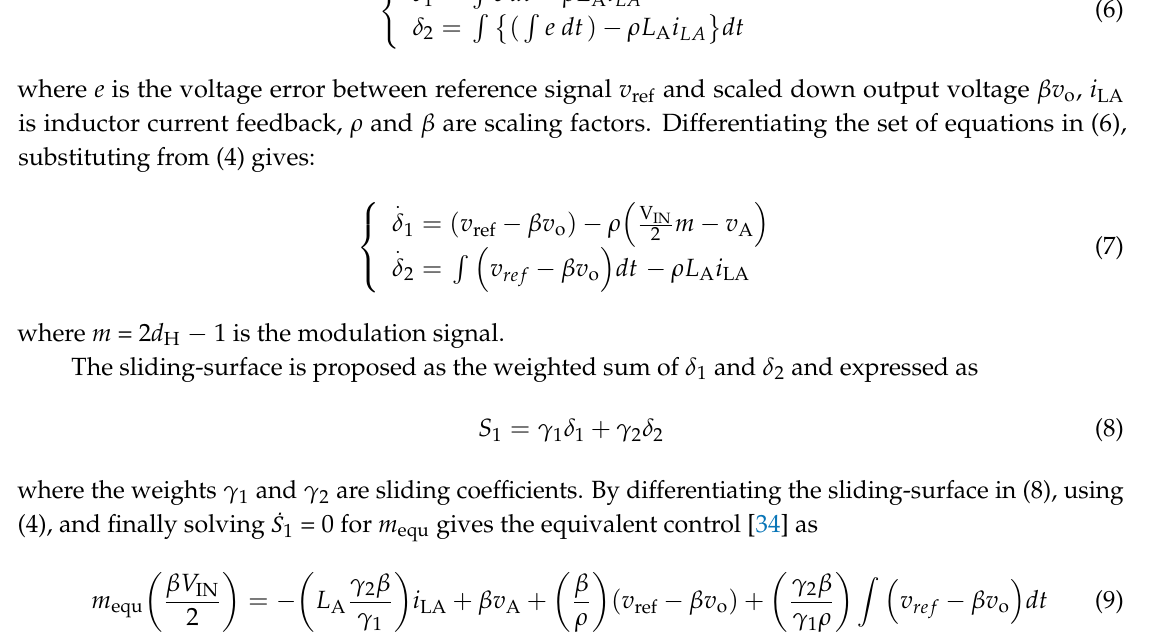
Table 1. Parameters of GaN class-D amplifier with fourth-order